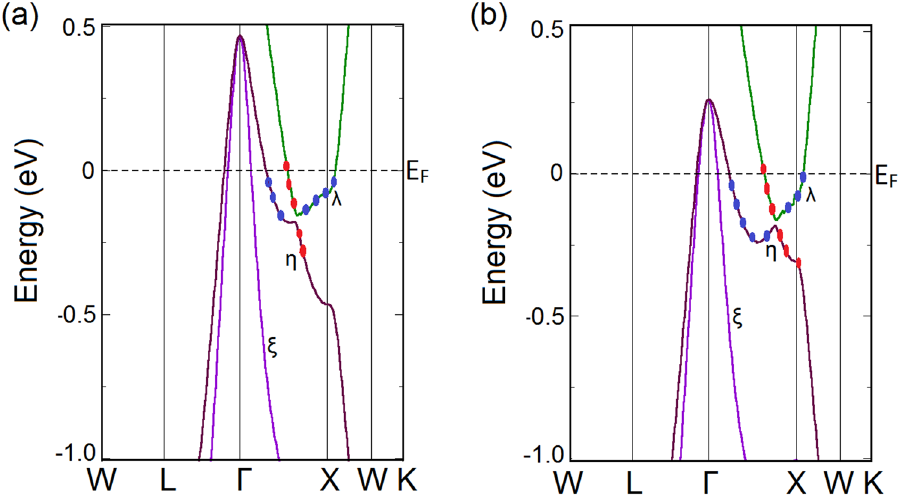
Figure 5. Calculated bulk band structures of LaBi with ( a ) LDA functional and ( b ) mBJLDA functional along the high symmetry k-path ( − − Γ − − − W L X W K ) shown in Fig. 1(b). Here, the red dots indicate the contribution of the La 5d orbitals and the blue dots show the contribution of the Bi 6p orbitals. The band inversion as indicated by the switching of the Bi-6p and La-5d orbitals between the valence and the conduction bands in ( a ) is still preserved and is in fact further consolidated in ( b